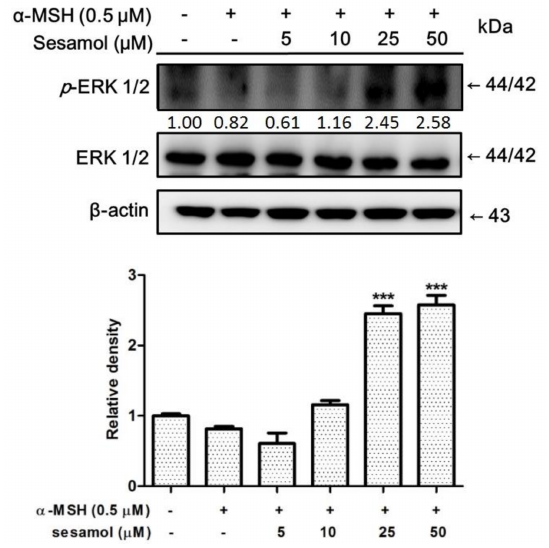
Figure 6. Effect of sesamol on α -MSH-induced protein expression of p -ERK in B16F10 cells. Each value is presented, in comparison with the α -MSH-treated group, as the mean ± SD. Significant difference versus α -MSH-treated group: *** p <